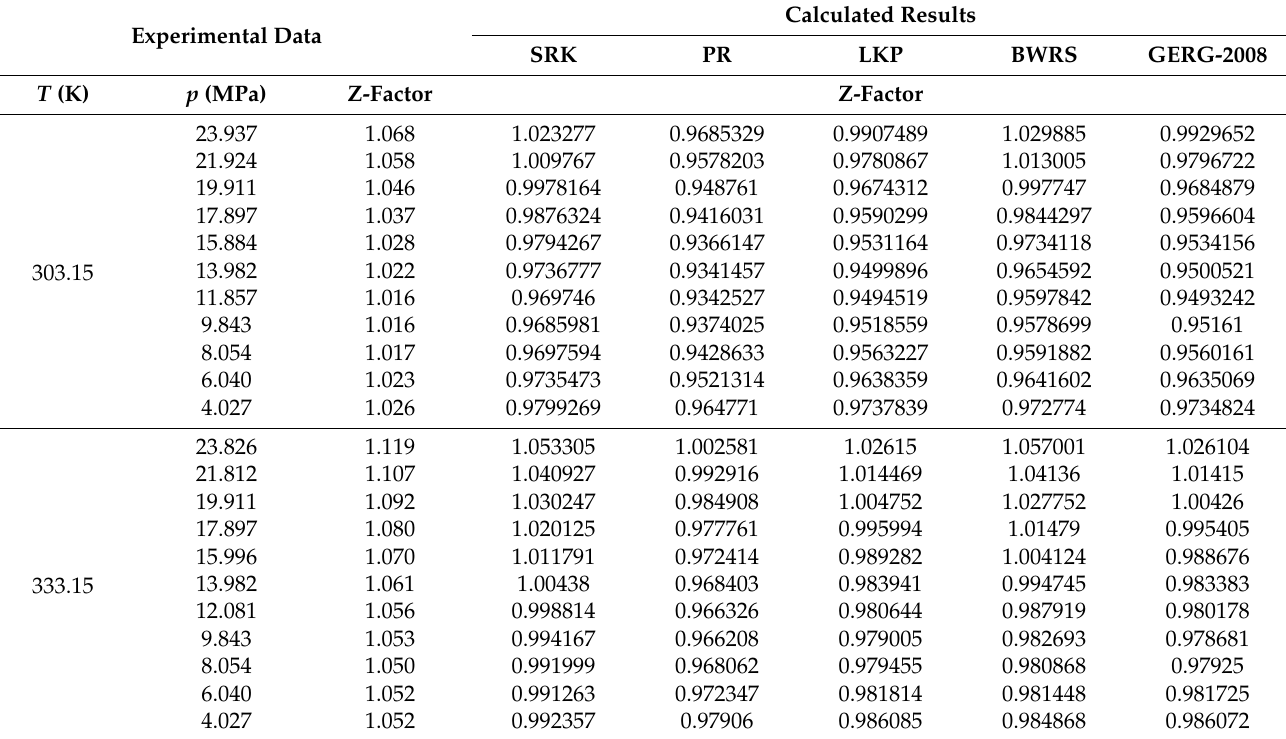
Table 6. Experimental data and calculated results of the compressibility factors for Sample 1. Experimental